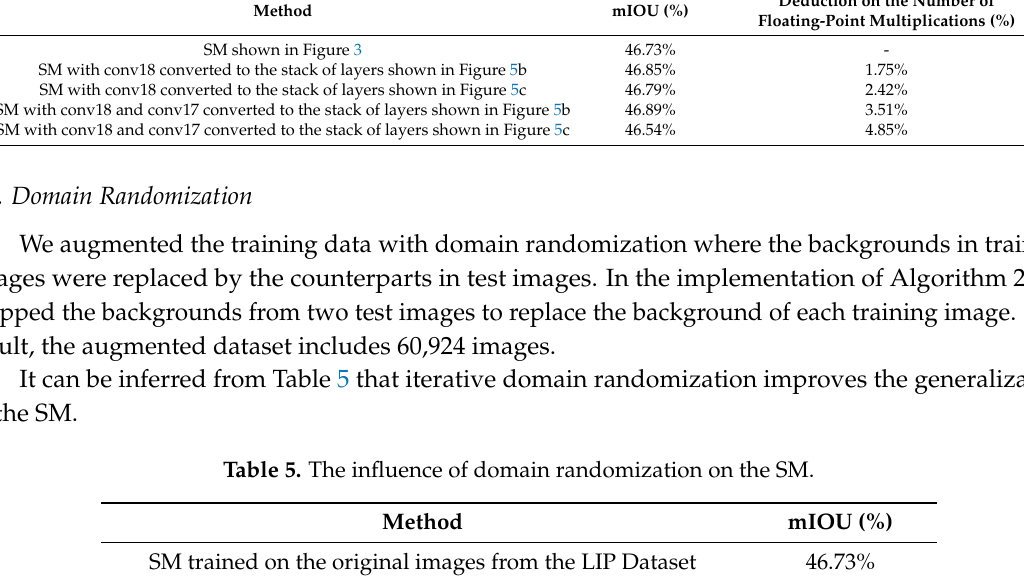
Figure 8. Performance comparison between the OM and the SM on the validation set. From the top row to the bottom row are input images, predictions from the SM, predictions from the OM and the ground truth labels.